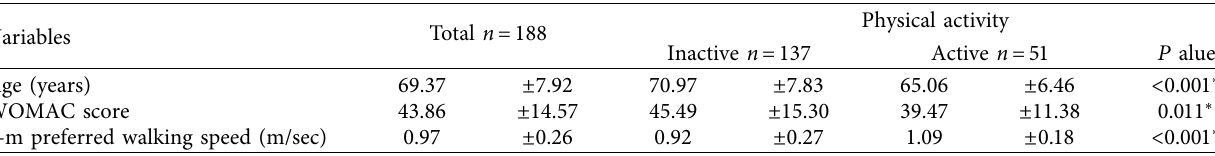
Table 2: The comparison of continuous variables between inactive and active physical activity groups in people with KOA ( n � 188). Variables